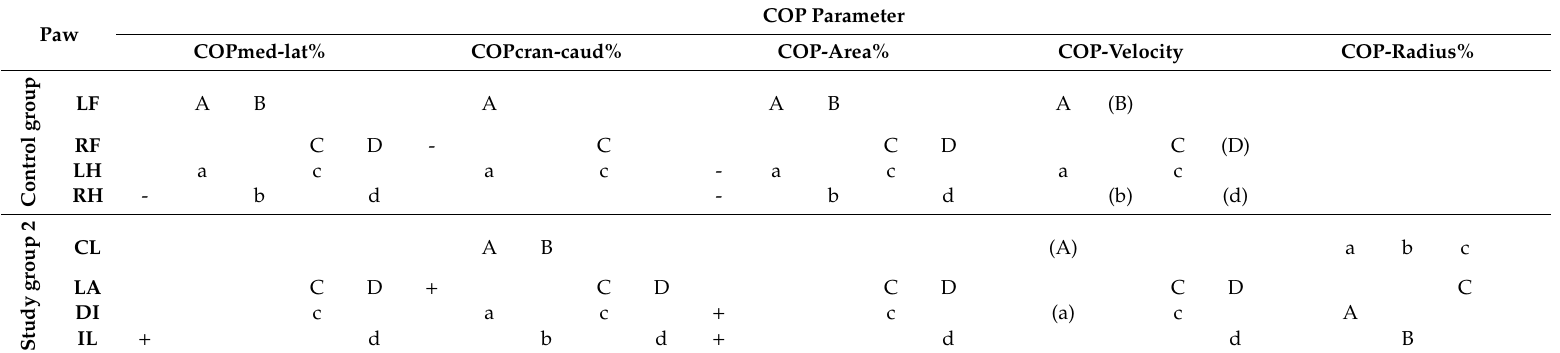
Table 2. Overview of the significant di ff erences in the COP parameters of study group 2 and control